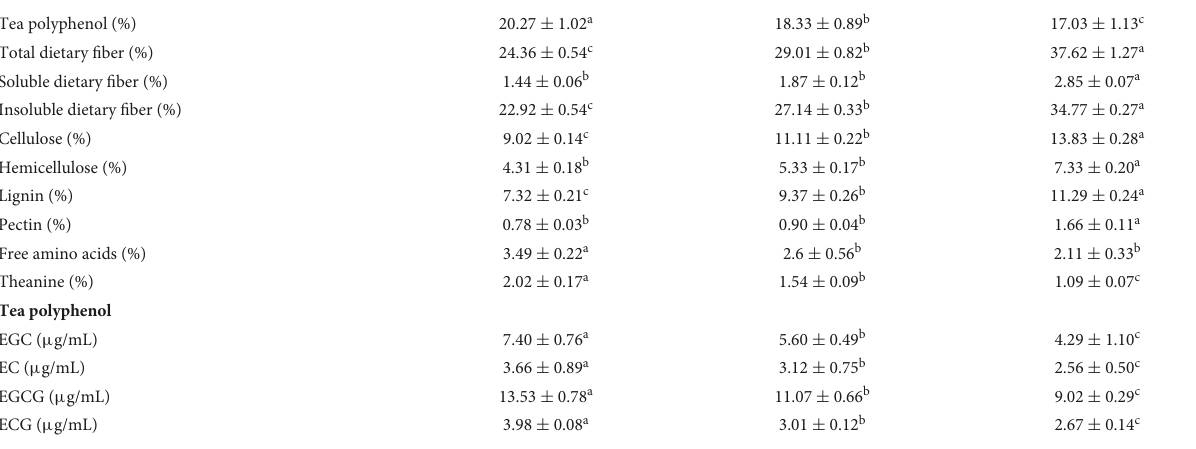
TABLE 2 The main active constituents of green tea